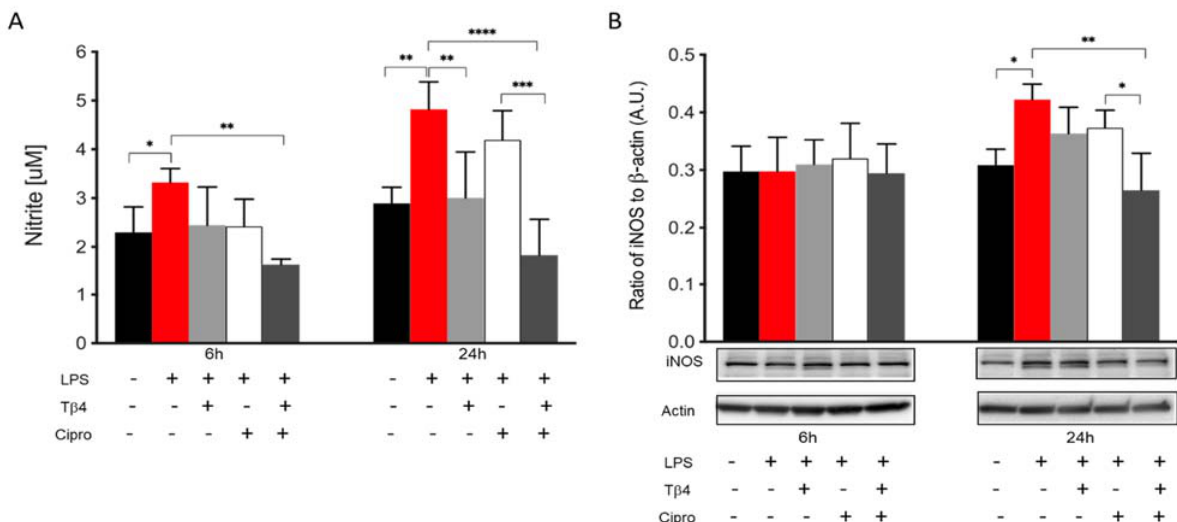
Figure 5. In vitro assessment of RNS generation following LPS-induced stimulation of M Φ . Nitrite ( A ) and iNOS ( B ) levels were measured from RAW 264.7 cells after 6 and 24 h of LPS stimulation. Nitrite results are reported as the mean concentration of nitrite ( µ M) ± SD of three independent experiments in triplicate. iNOS levels are normalized to β -actin ± SD. The blot is representative of four independent experiments. n = 4 corneas/group; * p < 0.05, ** p < 0.01, *** p < 0.001, **** p < 0.0001.